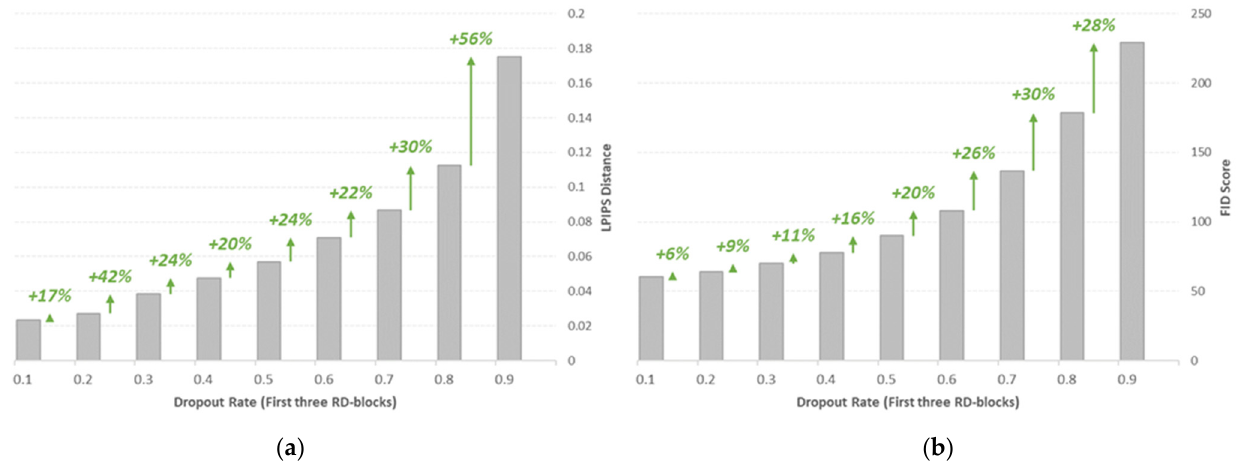
Figure 9. ( a ) LPIPS and ( b ) FID metrics of the synthetic images generated with different dropout rates in the inference mode. Performance metrics are summarized in Table S1.